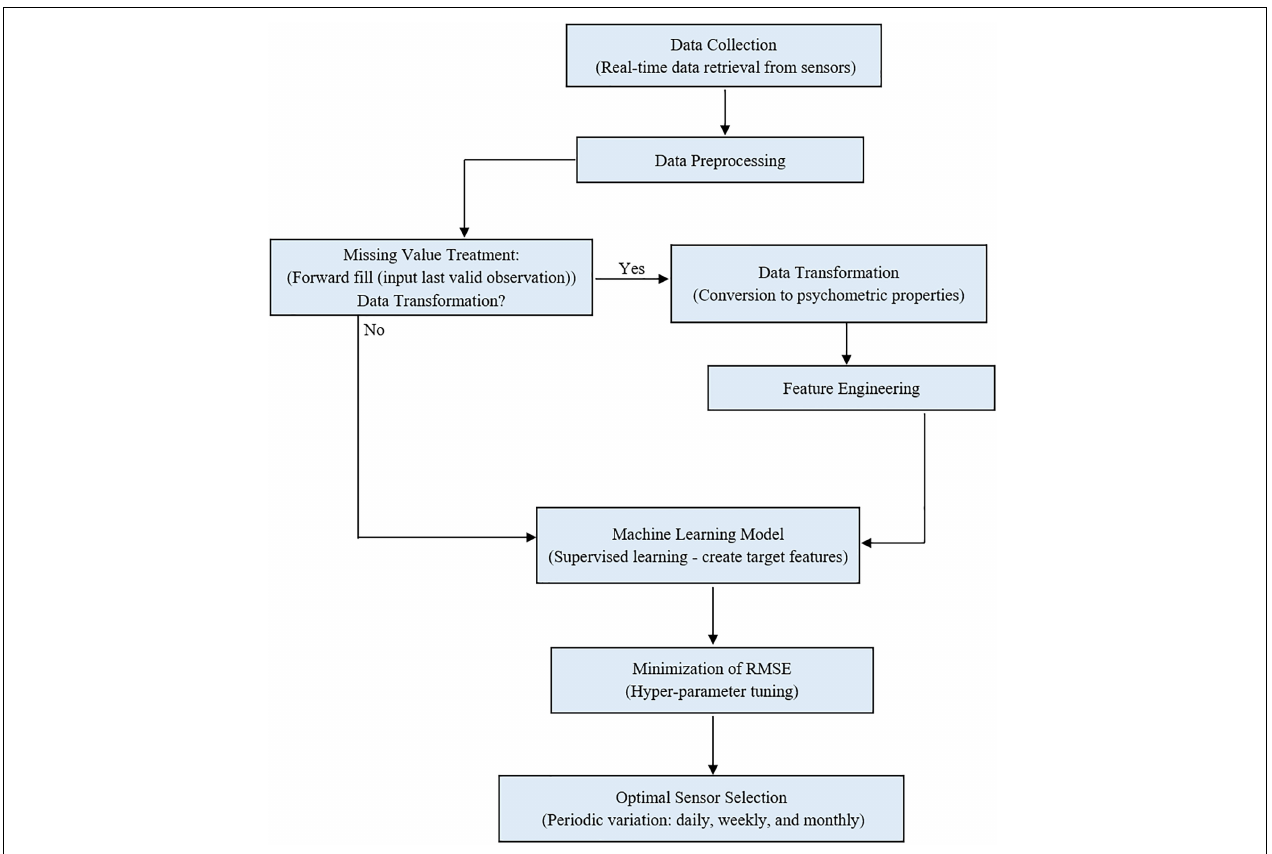
FIGURE 1 | Workflow for optimal sensor selection using (state method) in a protected cultivation system.